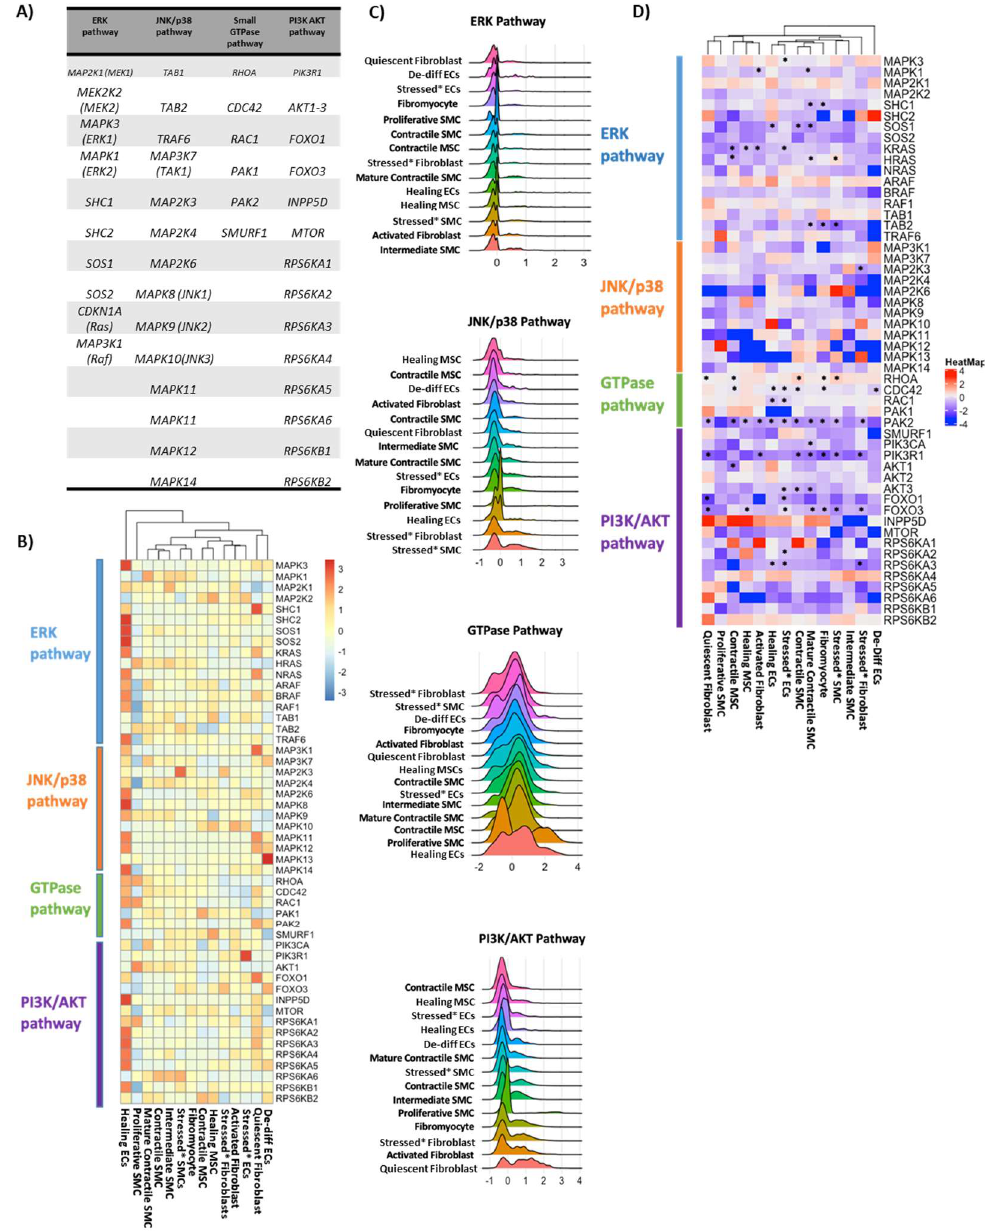
Figure 7. Expression of genes involved in the TGF-β pathway. ( A ) Genes studied in each non-canonical pathway. ( B ) Expression profiles of the different genes involved in non-canonical TGF-β signaling in non-immune cells. ( C ) Module score of genes involved in each non-canonical TGF-β pathway. In all figures, the clusters are ordered based on expression levels with the highest level first. ( D ) Differential expression of genes involved in the non-canonical TGF-β pathway in MFS compared to control tissues. Data are visualized as log2FC in MFS compared to control. * Clusters with significant differential expression (adjusted p value < 0.05). ECs, endothelial cells; MSC, mesenchymal stem cells; SMC, smooth muscle cells.